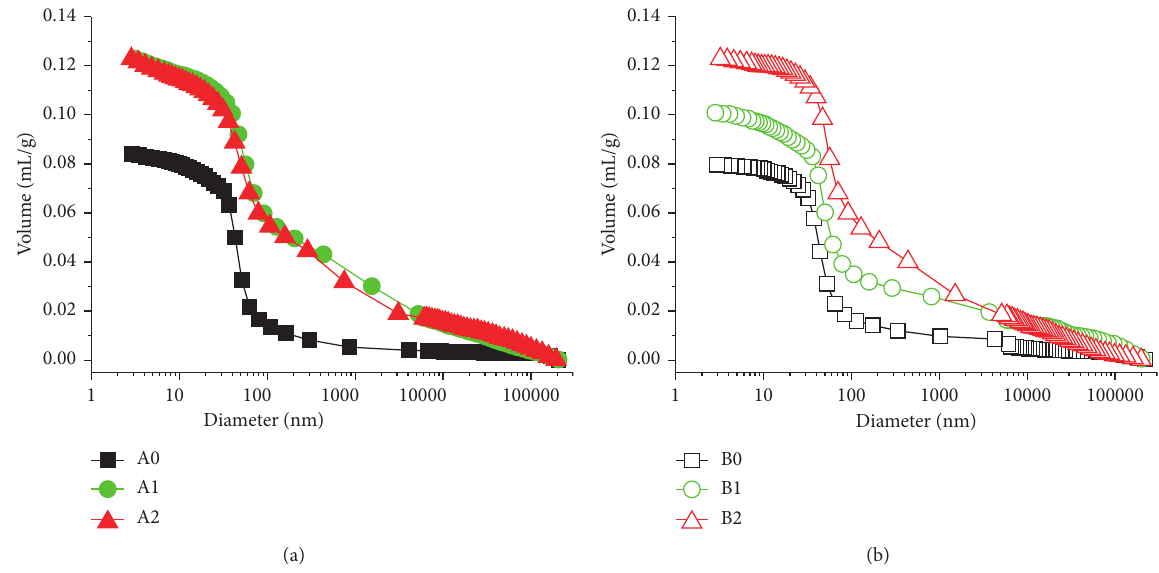
Figure 10: Effects of SAP on pore structure (cumulative pore size distribution) in the hardened cement pastes at the age of 56 days determined by MIP. (a) Harden pastes without FA; (b) harden pastes with